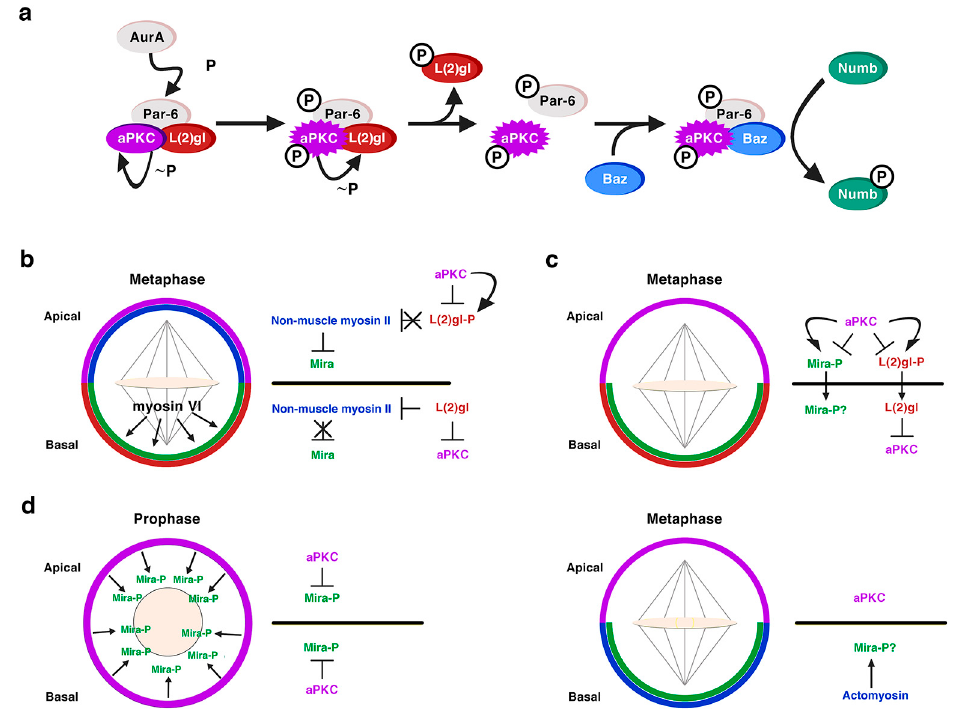
Figure 4. L(2)gl in asymmetric NB division. ( a ) L(2)gl forms part of an inactive Par complex. At metaphase, the kinase AurA phosphorylates Par6, which leads to the activation of aPKC and the consequent phosphorylation of L(2)gl by active aPKC. P-L(2)gl then leaves the Par complex and it is replaced by Baz / Par-3, which binds both aPKC and Numb making possible the phosphorylation of Numb by aPKC and the exclusion of P-Numb from the apical cortex. (Modified from Wirtz-Peitz et al., Cell, 2008). ( b ) Myosin-dependent model to explain the basal sorting of the adaptor protein Mira. aPKC phosphorylates and inactivates L(2)gl at the apical pole of metaphase NBs. Hence L(2)gl cannot bind and inactivate myosin II, which excludes Mira from the apical cortex. Myosin VI would help to locate Mira in a basal crescent. L(2)gl is active at the basal pole inhibiting both aPKC and myosin II, allowing in this way the accumulation of Mira at this location. ( c ) Myosin-independent model to explain the basal sorting of Mira. Apical aPKC directly phosphorylates both L(2)gl and Mira